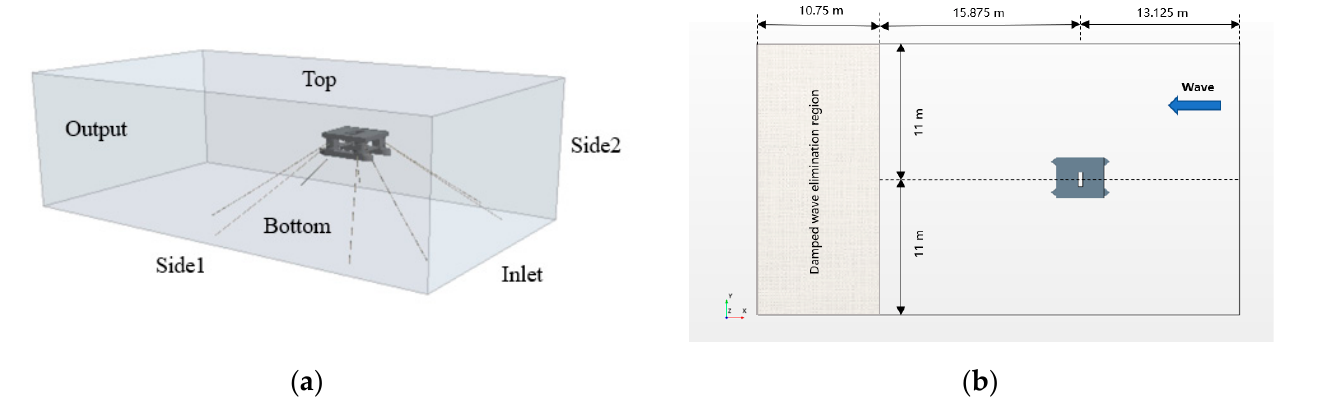
Figure 8. ( a ) Computational domain and boundary conditions; ( b ) The dimensions of the computational domain.